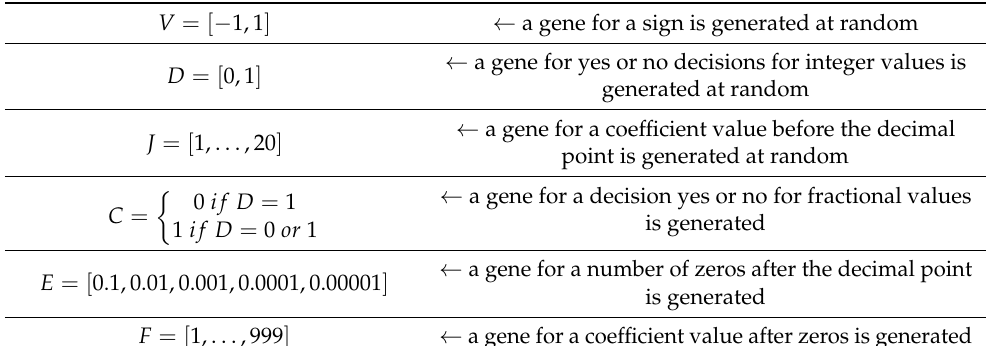
Table 1. DNA library of genes for each sub-chromosome generation.